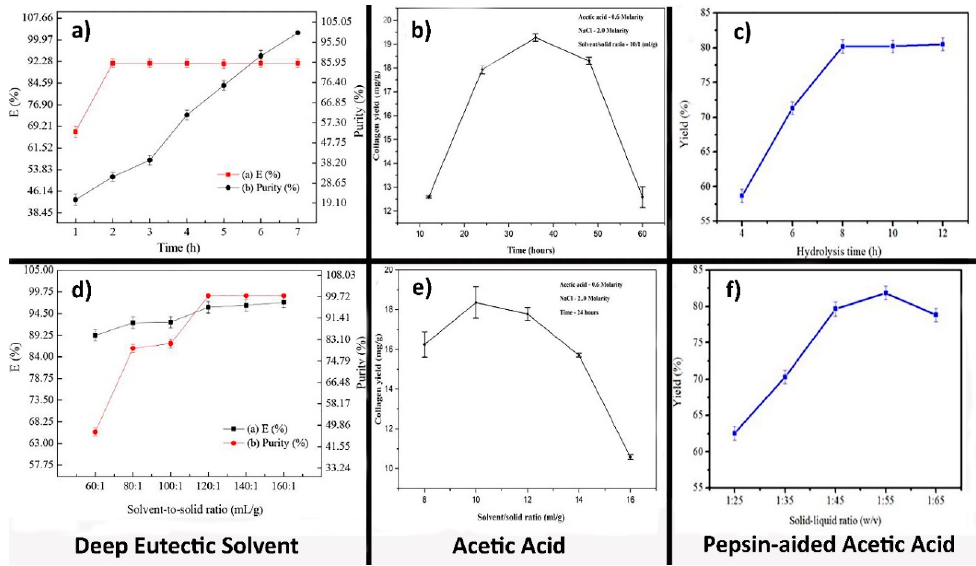
Figure 4. Effect of time and solid/liquid ratio on the yield of collagen from ( a , d ) cod skin [77] Copyright (2017) American Chemical Society. ( b , e ) sole fish skin, reprinted from with